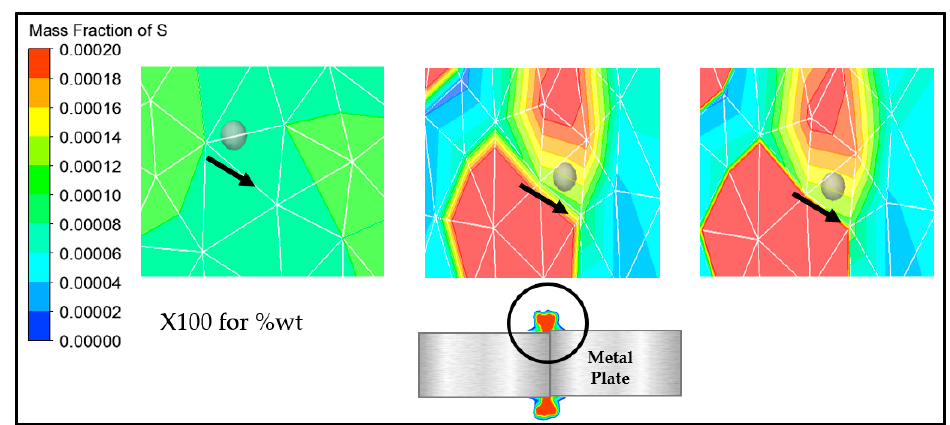
Figure 14. Mass fraction of sulfur during solidification Figure 14. M ass fraction of sulfur during solidification process.